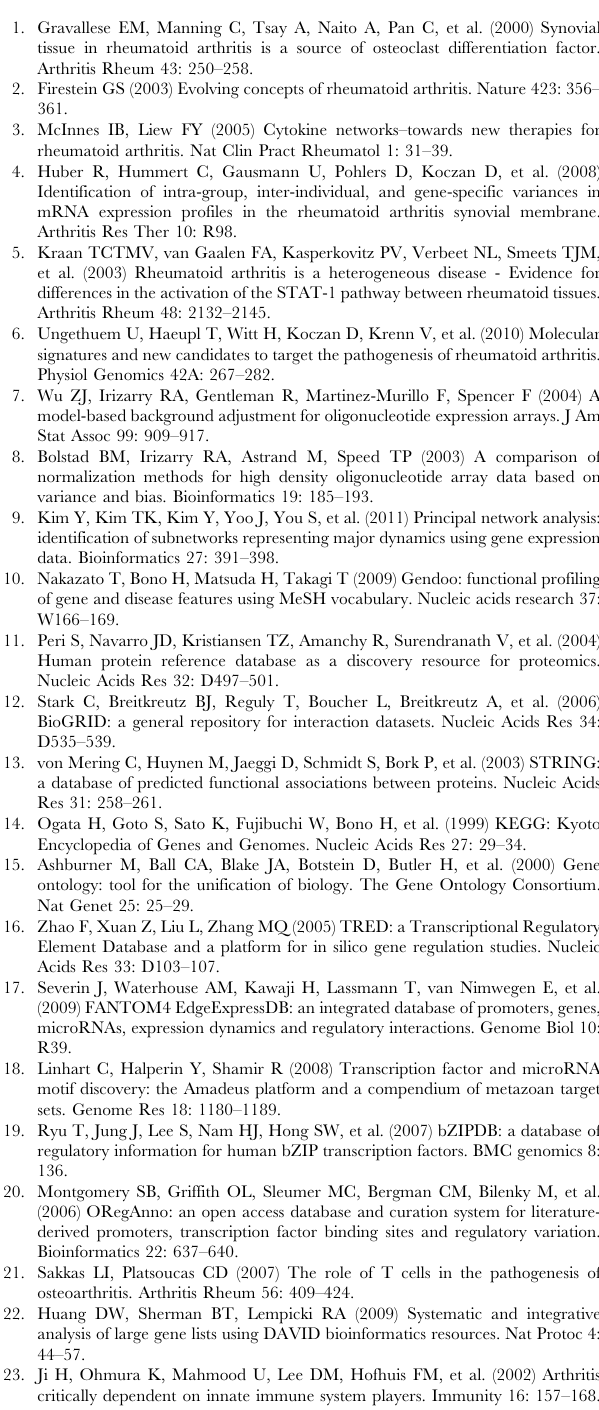
Table S1 108 molecular target candidates categorized by their associated modules in RA-perturbed network. (DOC) Table S2 19 key transcription factors categorized by their associated modules in RA-perturbed